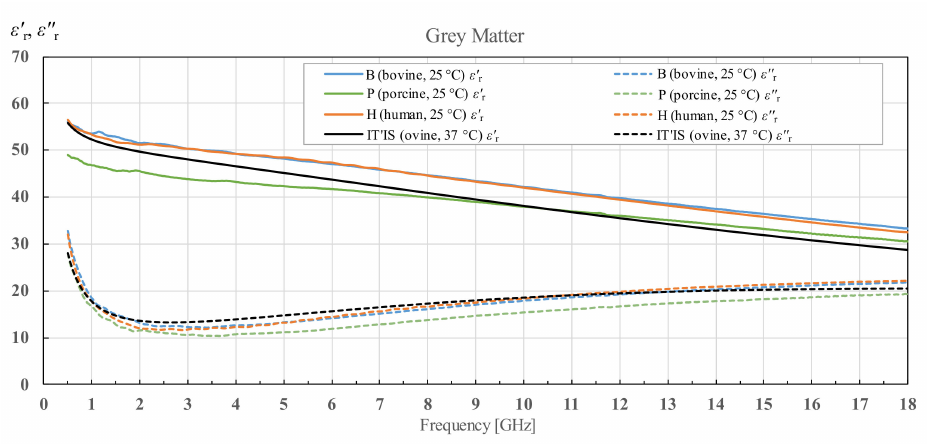
Figure 19. Grey matter permittivity comparison of averaged bovine brains (B), averaged hu- man brains (H) and a porcine brain (P) as well as comparison with the published data from IT’IS database